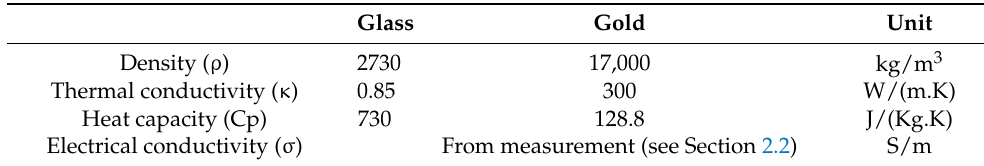
Figure 4. COMSOL simulated structure (metallic SPR surfaces are symbolized by yellow color). Table 1. Material parameters used in the COMSOL simulation.